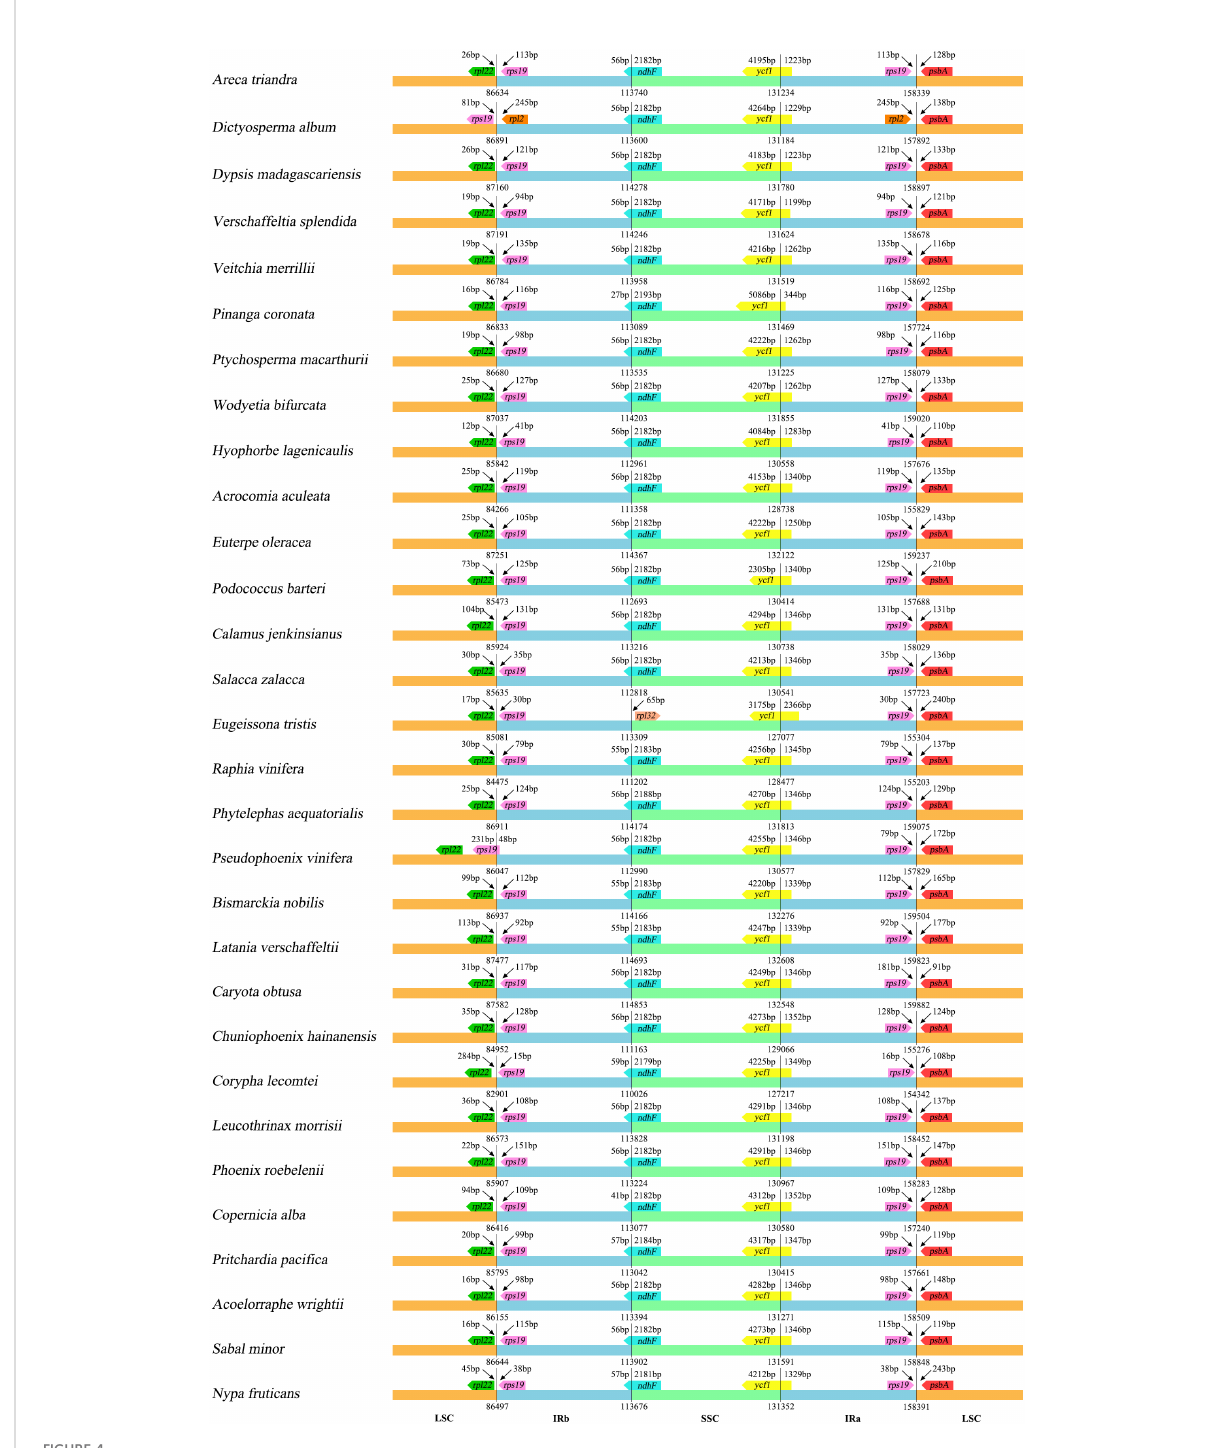
FIGURE 4 Comparison of the SC/IR junctions of 30 representative chloroplast genomes in